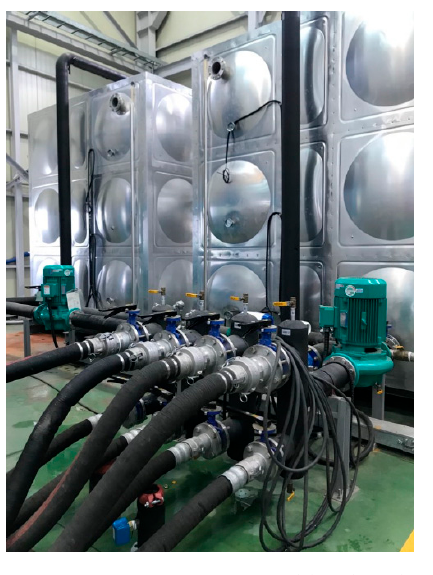
Figure 6. Test bed. Figure 6. Test bed.